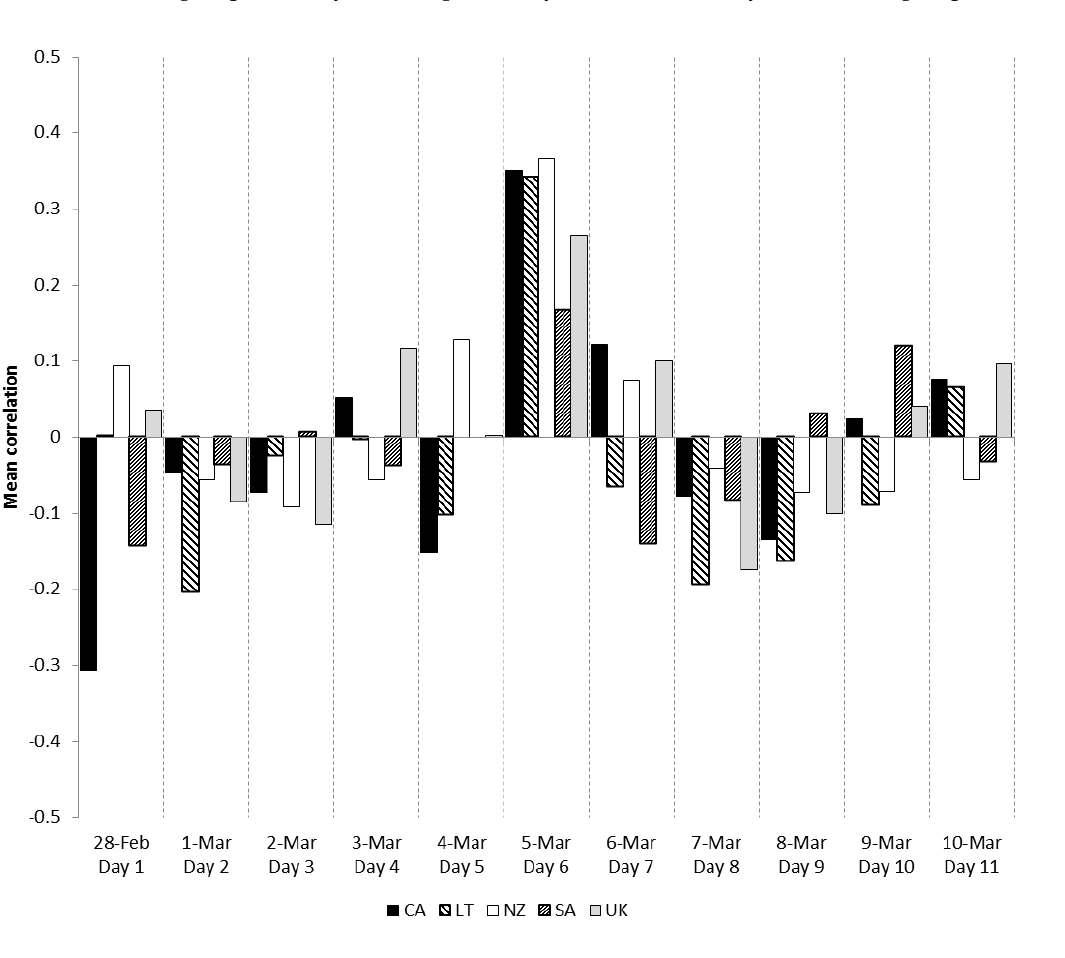
Figure 2. Mean LMF-HRV-correlations by Day and group (Abbreviations CA, LT, NZ, SA and UK correspond to California, Lithuania, New Zealand, Saudi Arabia and United Kingdom, respectively). Note that the only day of study period where all the groups’ HRV was positively correlated with the LMF was on the day 6, which was the day of the HLI and the correlations between the HRV and LMF for all the groups were substantially higher on that